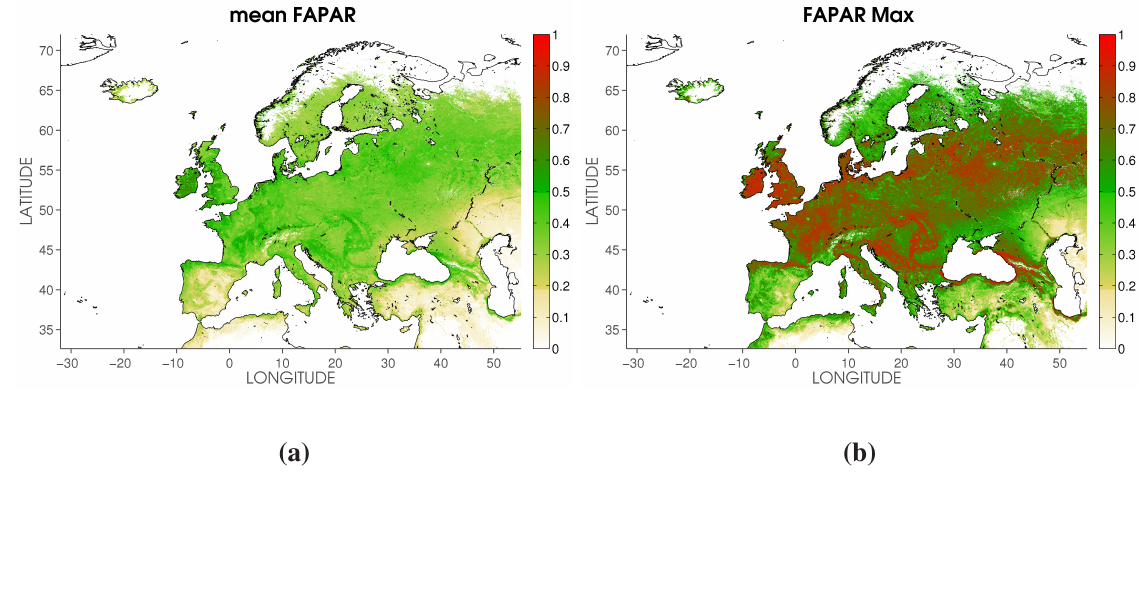
Figure 1. The spatial distribution of climatological averages for 1998–2011, for vegetation metrics: ( a ) mean Fraction of Absorbed Photosynthetically Active Radiation (FAPAR) (-); ( b ) FAPAR max (-); ( c ) growing season length (GSL) (days); and ( d ) cumulative FAPAR of the growing season (CGS)